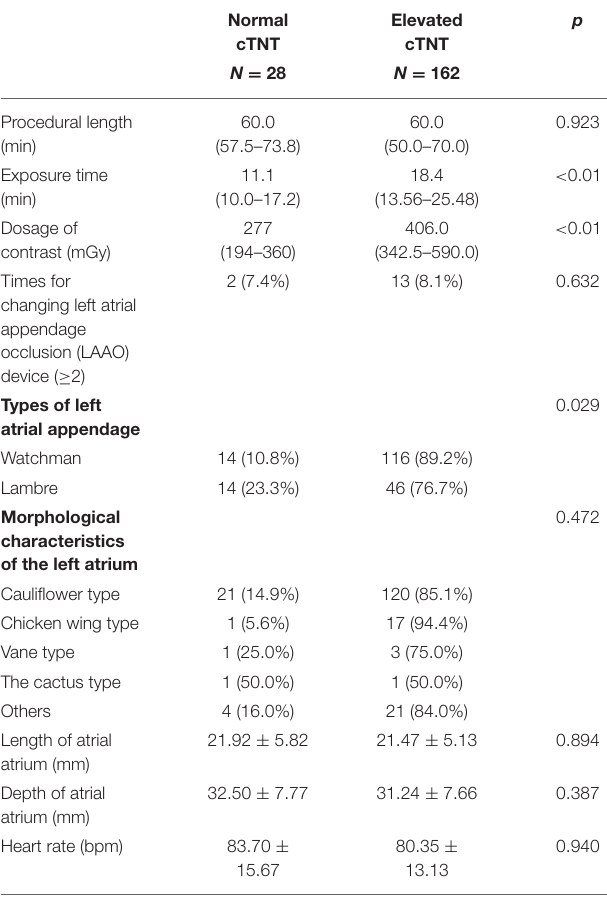
TABLE 2 | Intraoperative information between the normal cTNT and elevated cTNT groups. Normal